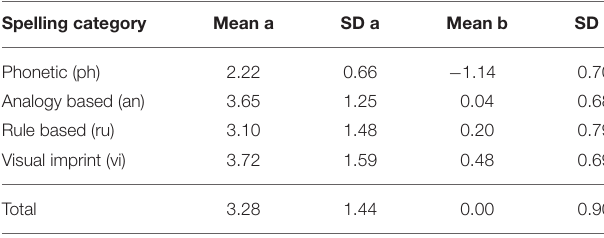
TABLE 1 | Item bank spelling item parameters per subcategory.